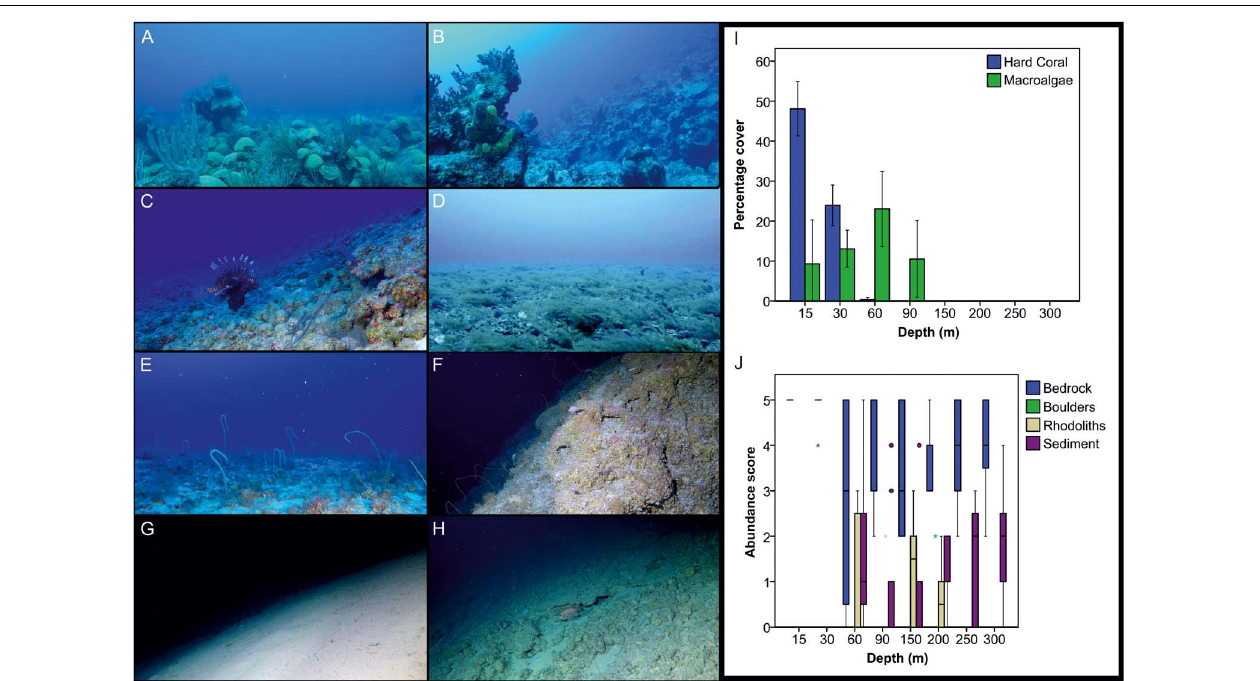
FIGURE 6 | Representative reef environments assessed in Bermuda (A–H) and changes in benthic composition with depth (I,J) . (A,B) Shallow reefs dominated by reef-building scleractinians creating complex three-dimensional habitat structures (15–30 m), (C) Rhodolith bed on reef slope (60 m), (D) Macroalgal fields (60 m), (E) Mosaic of sand and bedrock (90 m), (F) Reef wall (150 m), (G) Flat, sedimented habitat (250 m), (H) Hard bottom habitat with patches of sand and gravel (300 m). (I) Change in percentage cover of hard coral and macroalgae with depth. The bars indicate the mean and 95% confidence intervals. (J) Change in substratum type (bedrock, boulders, rhododiths, sediment) with depth. Boxes indicate the 25th and 75th quantiles, whiskers are 1.5 the interquartile, circles are outliers, and asterisks extreme outliers. Abundance scores relate to estimated percentage coverage (1: 1–10%, 2: 11–40%, 3: 41–60%, 4: 61–90%, 5: 91–100% – see section “ Benthic Data in Materials and Methods”). Image credits (A–H) : PV Stefanoudis, Nekton Foundation.